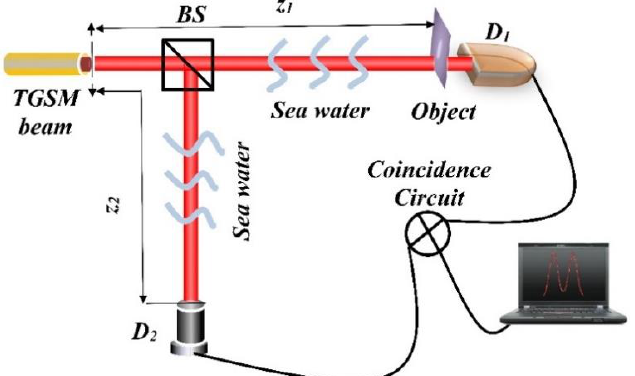
Figure 1. Schematic for ghost imaging with a twisted Gaussian Schell-model (TGSM) beam in a turbulent ocean. BS, beam splitter; D 1 , D 2 , detectors.